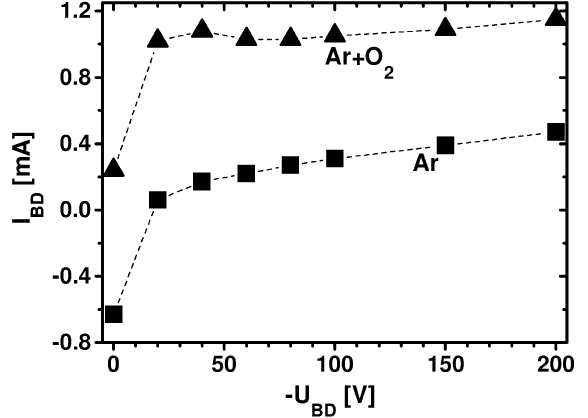
FIG. 2. Extracted currents of Ar 8 1 as a function of the disk voltage for the case of plasmas of pure argon (squares) and Ar 1 O 2 gas mixing